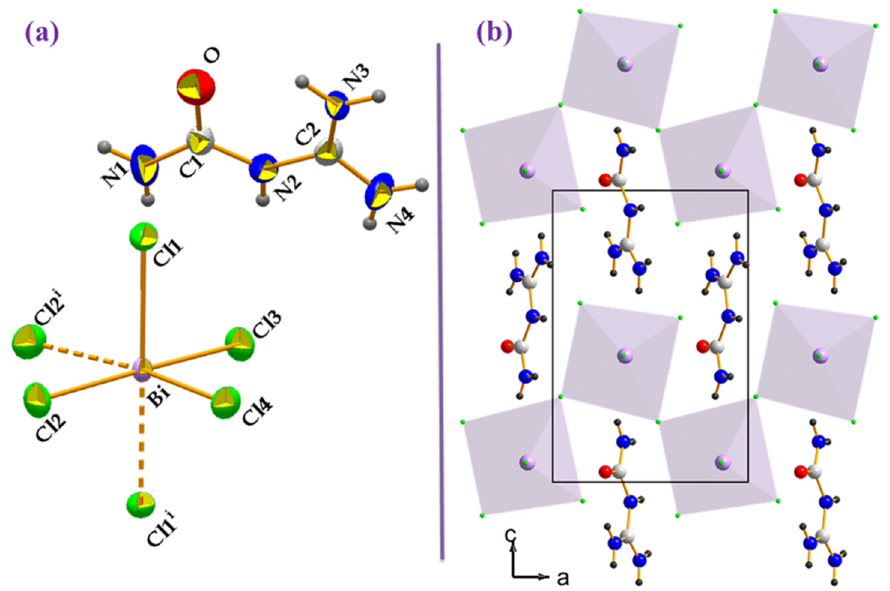
Figure 1. ( a ) Atoms numbering in (C 2 H 7 N 4 O) 2 BiCl 5 . ( b ) Atomic arrangement of (C 2 H 7 N 4 O) 2 BiCl 5 . The chains of corner-sharing BiCl 6 octahedra form the inorganic parts.